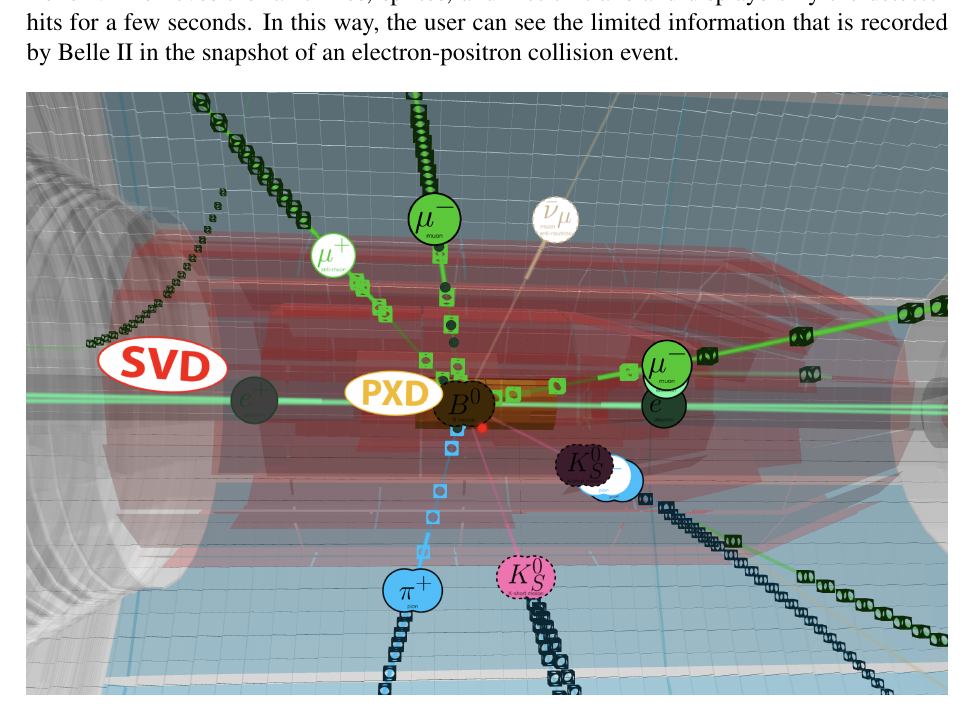
Figure 1. Snapshot of the animation of a typical e + e − → Υ (4 S ) → B 0 ¯ B 0 event, where B 0 → J /ψ K 0 ( µ + µ − )( π + π − ) and ¯ B 0 → D + µ − ν µ . The snapshot shows the faint lines for the entire event history, the sprites for and trails behind each particle, and the hollow cubes at each of the hits in the sensitive elements of the detectors. The B 0 sprite is at the centre of the pixel detector (PXD) that is contained within the five-layer silicon vertex detector